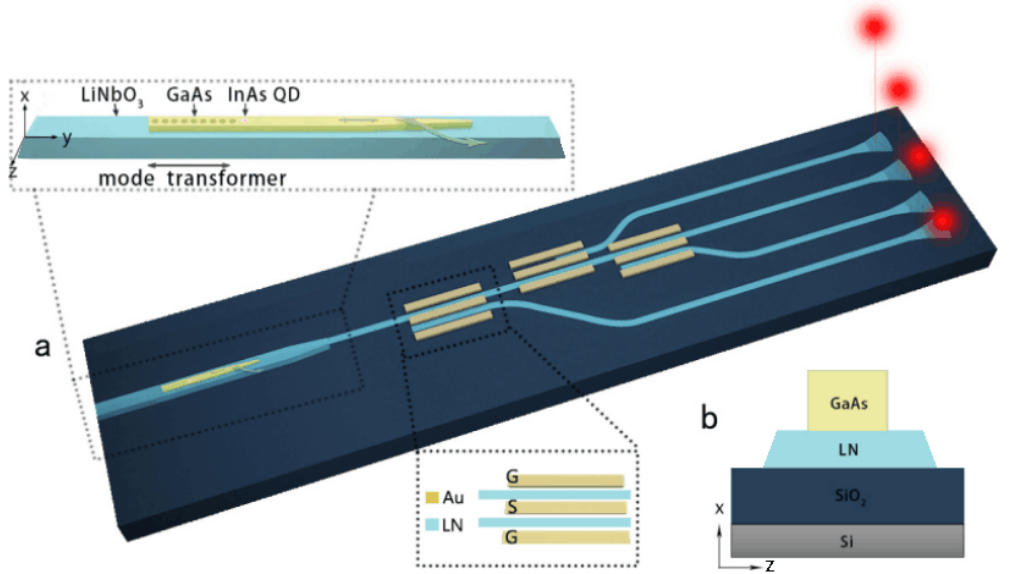
Figure 1. ( a ) Schematic diagram of proposed InAs-GaAs-LiNbO 3 chip. Inset: zoom-in of the single photon source part integrating an InAs/GaAs quantum dot (QD), LiNbO 3 waveguide chip, and LiNbO3 directional coupler; ( b ) the cross- section view of the photon source part.